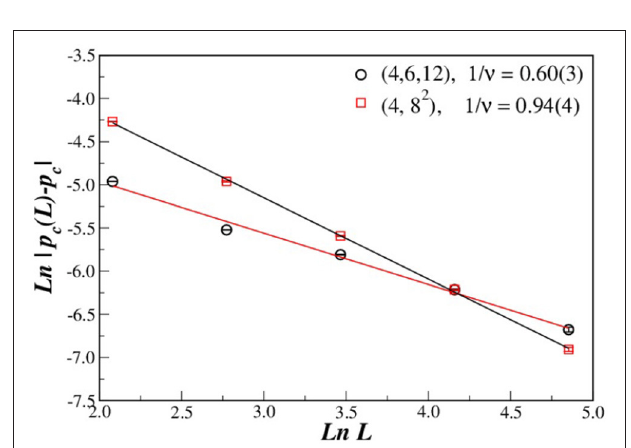
FIGURE 4 | Log-log plot of the OF at p c vs. L for (4,6,12), and (4,8 2 ) AL. Fitting data, we obtained the estimation for the critical ratio γ/ν .